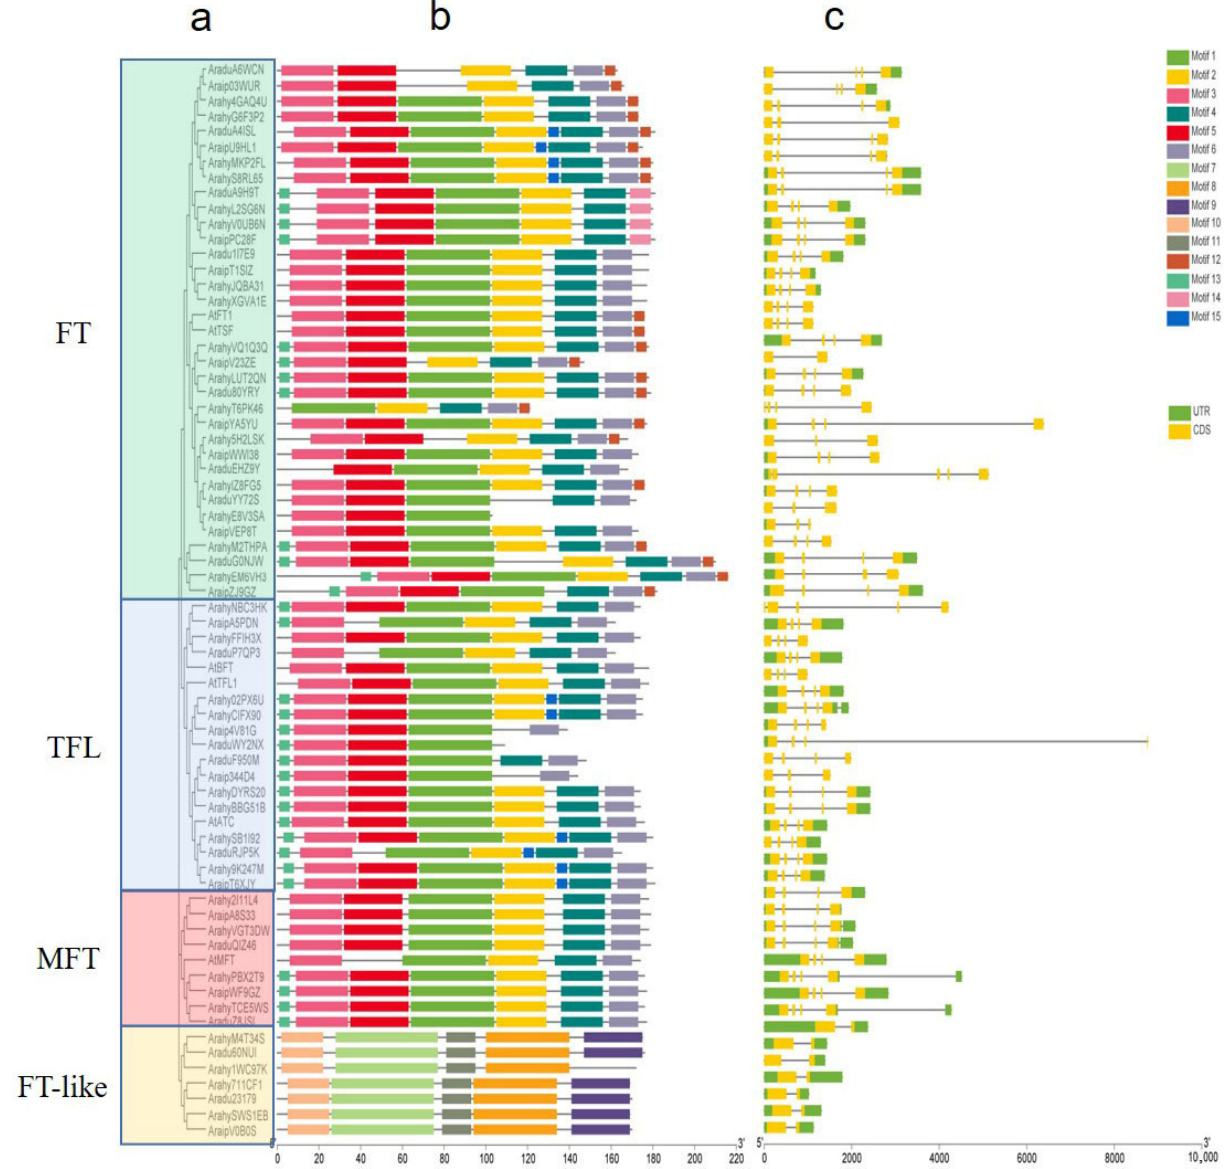
Figure 1. The phylogenetic tree, motifs and gene intron/exon structure of 64 PEBP genes in cultivated peanuts. ( a ) Phylogenetic tree based on PEBP protein sequence using Neigbour-joining Tree method. ( b ) The motif compositions of PEBP proteins. Specific motifs were indicated using different colors. ( c ) The exon and intron distribution of PEBP genes. Exons and intron regions are represented by yellow rectangles and grey lines, respectively.